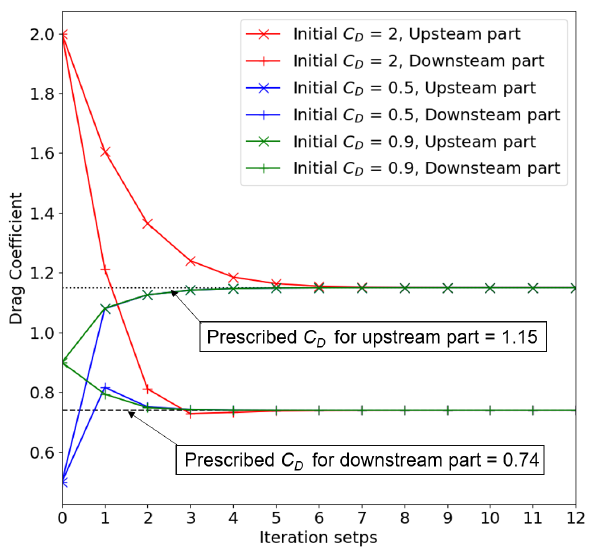
Figure 9: Drag coefficients identified by the PID regu- lators for the 2-panel configuration.